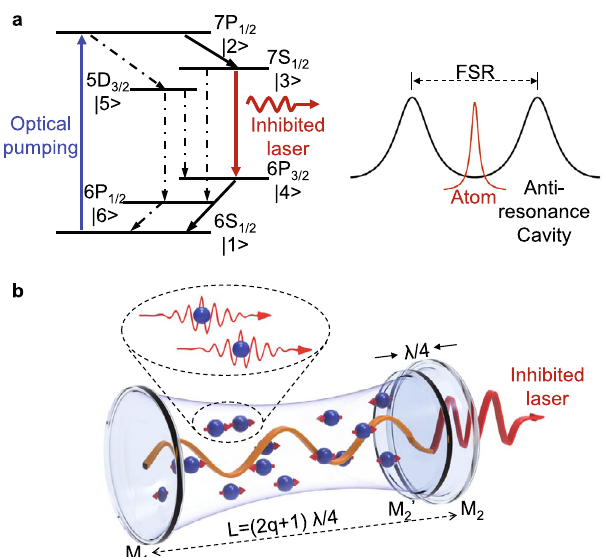
Fig. 1 Working principle of the inhibited laser. a Level scheme for 133 Cs atom showing the 459 nm transition used for pumping and the 1470 nm transition as the inhibited lasing. Cs atoms are pumped by a 459 nm laser, which drives the 1 j i (6S 1/2 ) to 2 j i (7P 1/2 ) transition. Atoms are then transferred to the 3 j i (7S 1/2 ) state through spontaneous radiation. Utilizing weak feedback of the cavity, population inversion is built up between the 3 j i and 4 j i (6P 3/2 ) levels, and fi nally, 1470 nm lasing is realized. The inhibited laser is realized in an anti-resonant cavity, where the atomic gain line is exactly at the center of two adjacent cavity resonances. b Sketch of the inhibited laser. Cs atoms (blue spheres) along the direction of the cavity mode are pumped by the 459 nm laser. Two cavity mirrors are coated with re fl ectivities of R 1 = R 2 = 34.5% at 1470nm. To change the cavity-mode frequency, the location of the output mirror is tunable. Generally, the round-trip optical path is exactly equal to an integer multiple of the intracavity wavelengths, and the output mirror is located at M 0 . However, 2 an inhibited laser (in red) is achieved when the round-trip optical path is equal to an odd multiple of the half wavelength 2 L = (2 q + 1) λ /2 with the output mirror being located at M 2